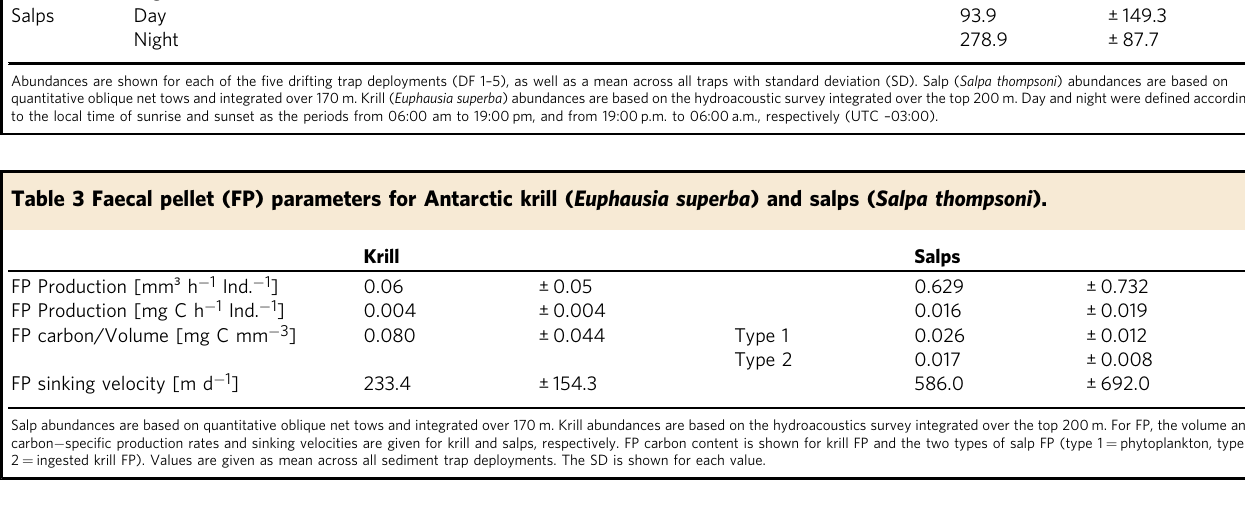
Table 2 Abundances of krill and salps at day and night.